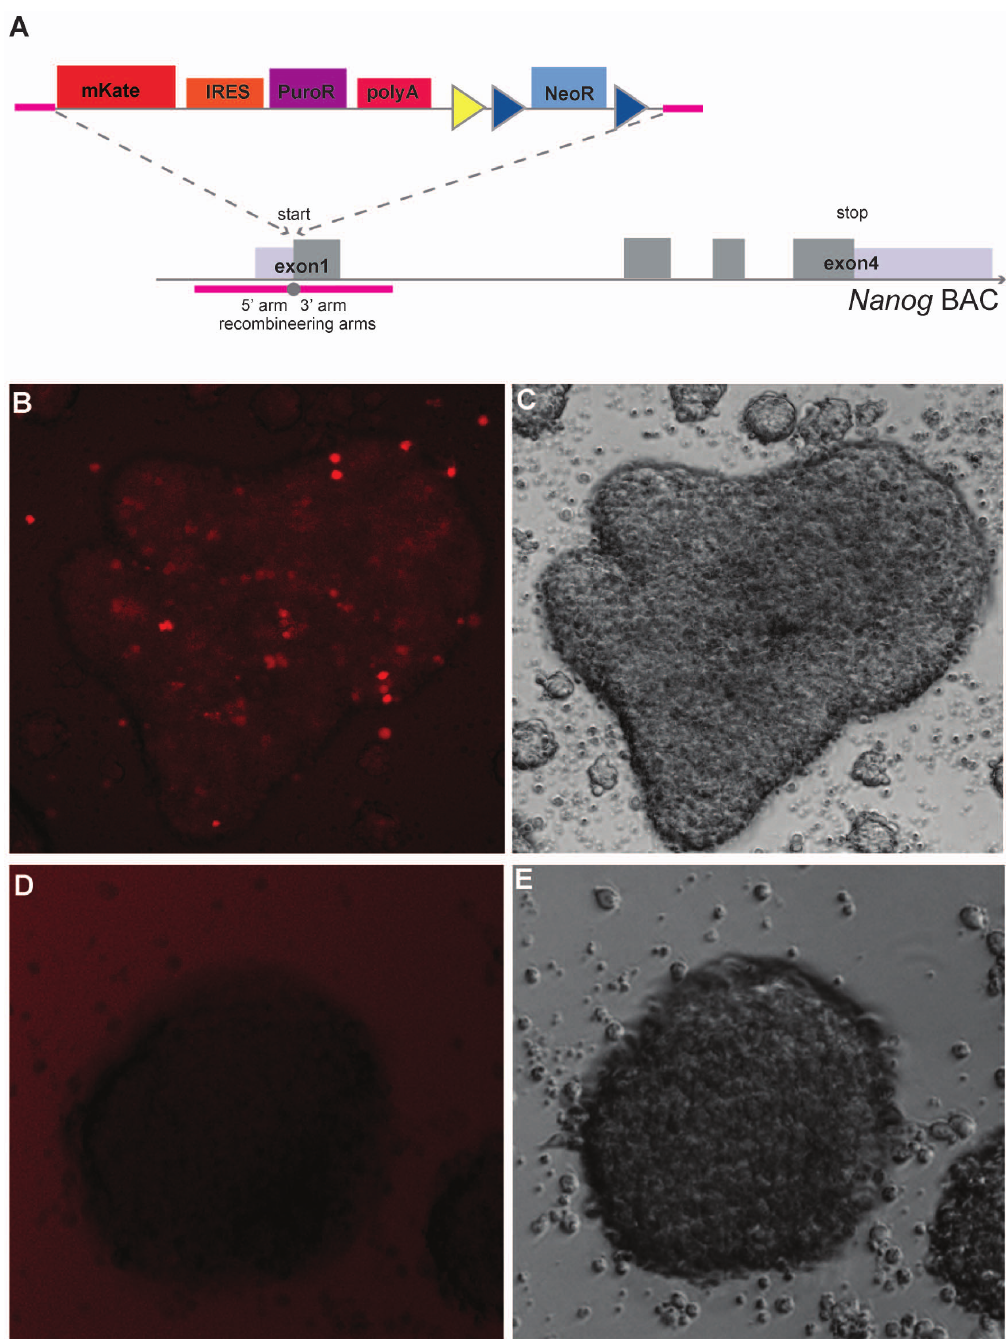
Figure 5. The Nanog -KiP BAC made from a modified pMULTIrec vector. A. Generation of the Nanog -KiP BAC. B, C. mKate2 (B) and brightfield signals of iPS clones derived from Nanog -KiP BAC MEFs. D, E. mKate2 (B) and brightfield signals of iPS clones derived from wild type MEFs.